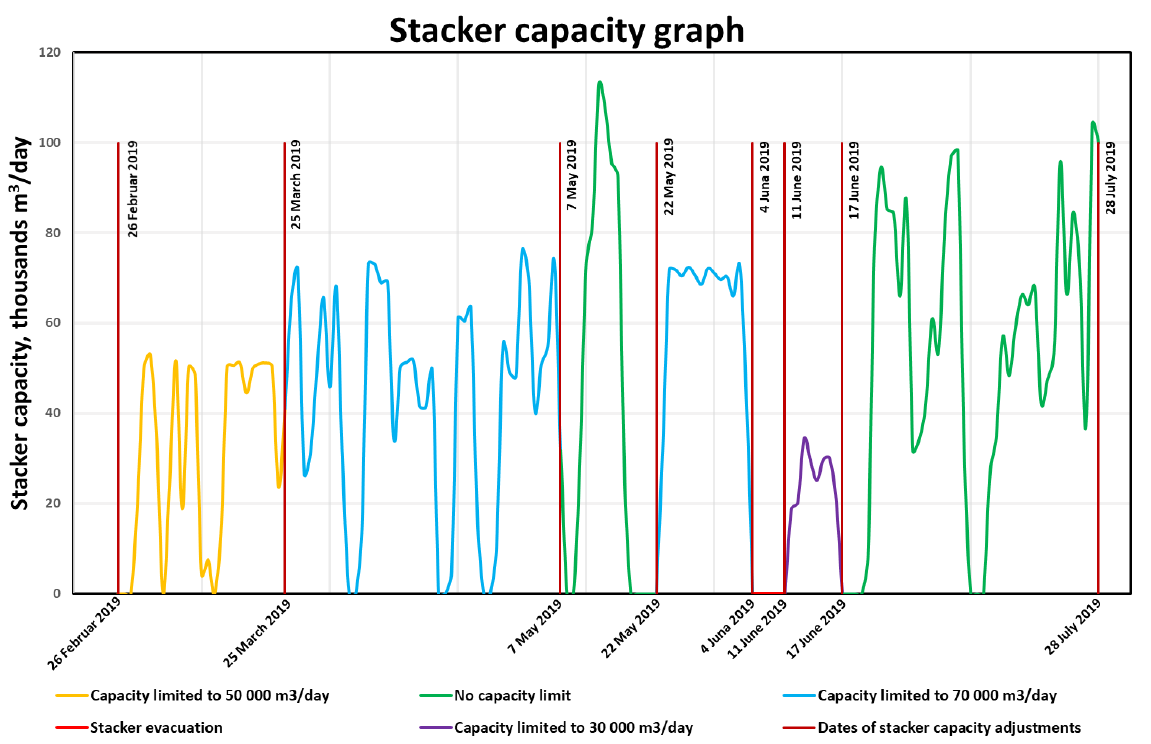
Figure 8: Capacity of stacker Z-48 over the analyzed 5-month